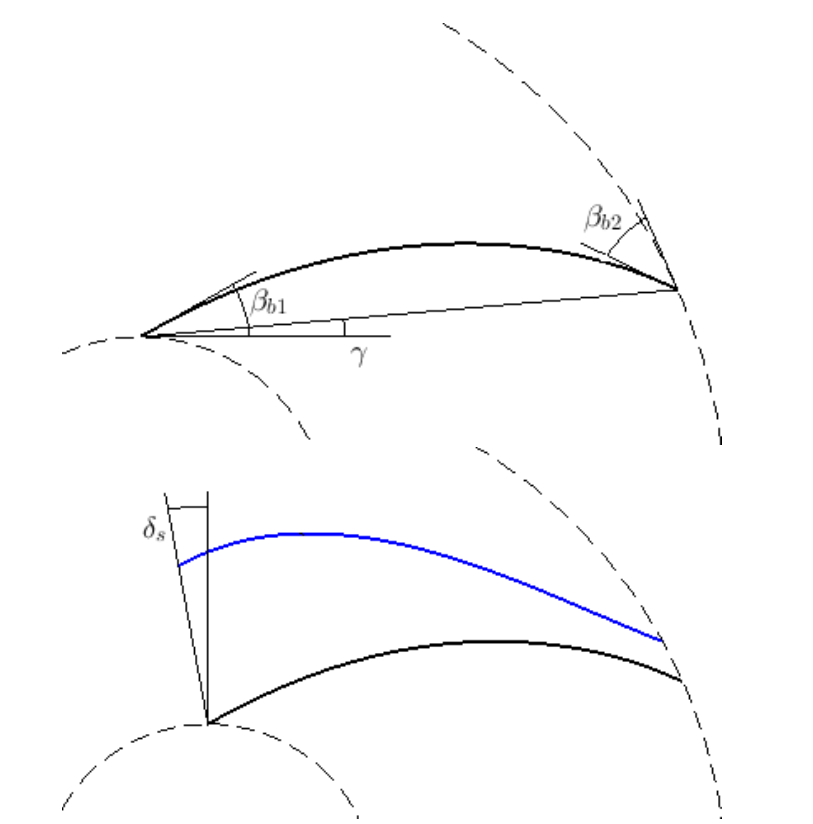
Figure 2. Main symbols for the impeller geometry ( top ), and impeller blade ( middle , bottom